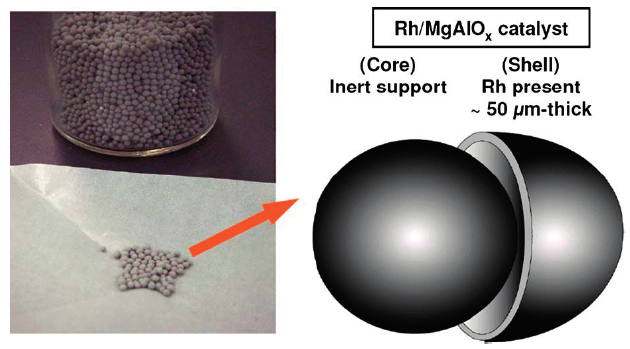
Figure 19. Catalyst structure schematic [34].